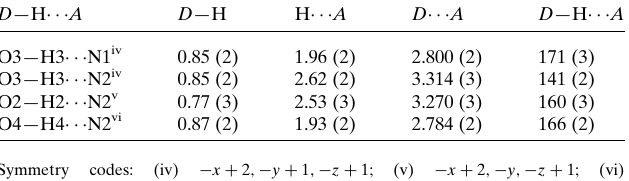
Table 4 Hydrogen-bond geometry (A˚ , (cid:5) ) for (II).